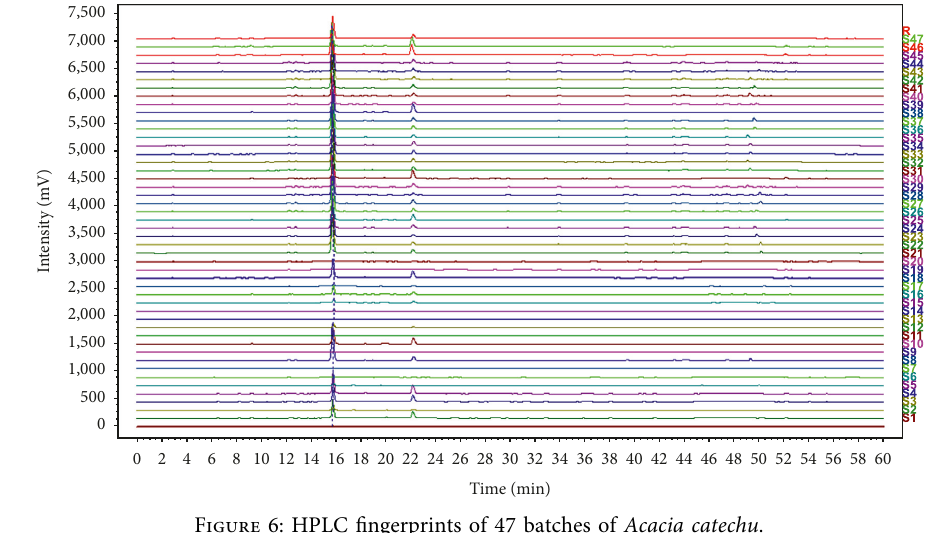
Figure 6: HPLC fingerprints of 47 batches of Acacia catechu .